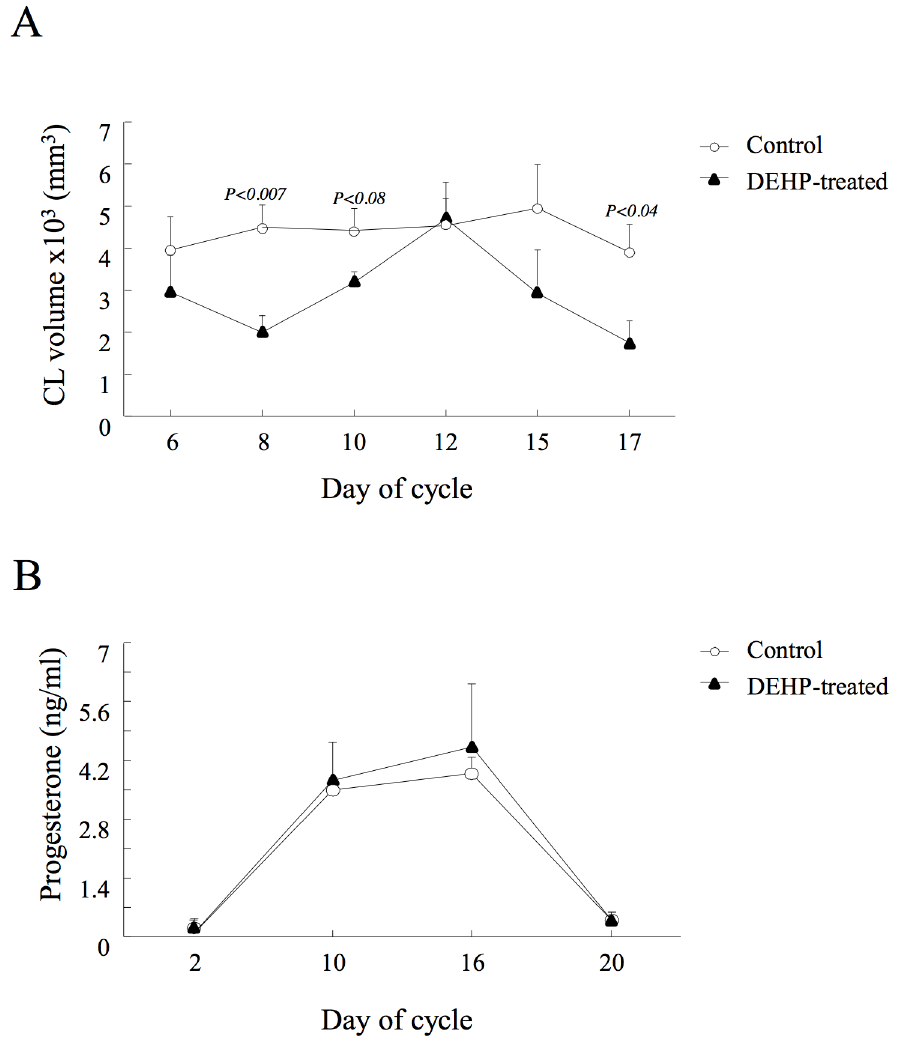
Fig 5. Effect of DEHP on corpus luteum (CL) size and function. Control and DEHP-treated cows were synchronized and ovarian follicular dynamics was monitored by linear ultrasonographic scanner throughout an entire cycle. (A) CL volume was calculated by its radius (R in mm), based on the scanned diameter, as 4 × π × R 3 /3, recorded on days 6 – 17 of the cycle. Data are presented as means ± SEM; P- value indicates treatment effect within experimental groups on each examined day. (B) Plasma progesterone concentrations during days 2 – 20 of the cycle. Data presented as means ± SEM; P -value indicates treatment effect within experimental groups on each examined